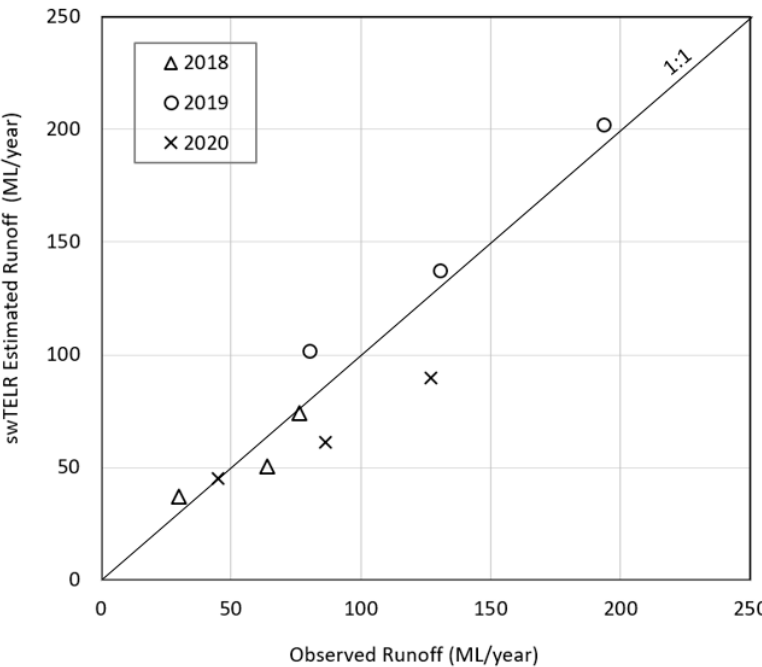
Figure 6. The swTELR annual runoff estimates compared to observed flows for the three study catchments.